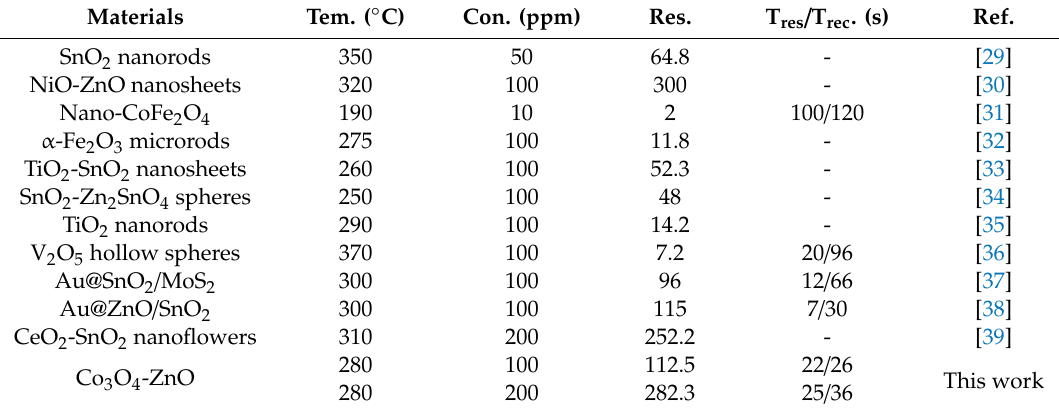
Table 2. TEA sensing properties of the sensors based on di ff erent materials (temperature, concentration, response, response time / recovery time; references were abbreviated as Tem, Con, Res, T res / T rec , and Ref,